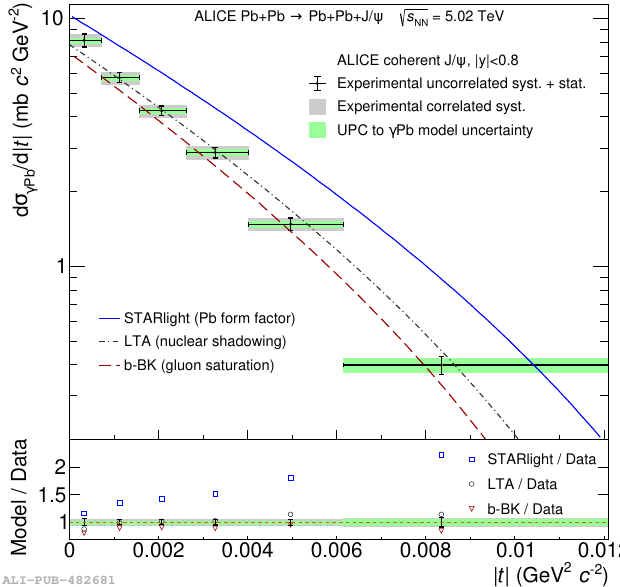
Figure 2: | t | dependence of the photonuclear cross section for the coherent J /ψ pho- toproduction compared with model predictions (top panel). Model to data ratio for each prediction in each measured point (bottom panel). The uncertainties are split between those originating from experiment and those originating from the correction to go from the UPC to the photonuclear cross section [ 6 ]